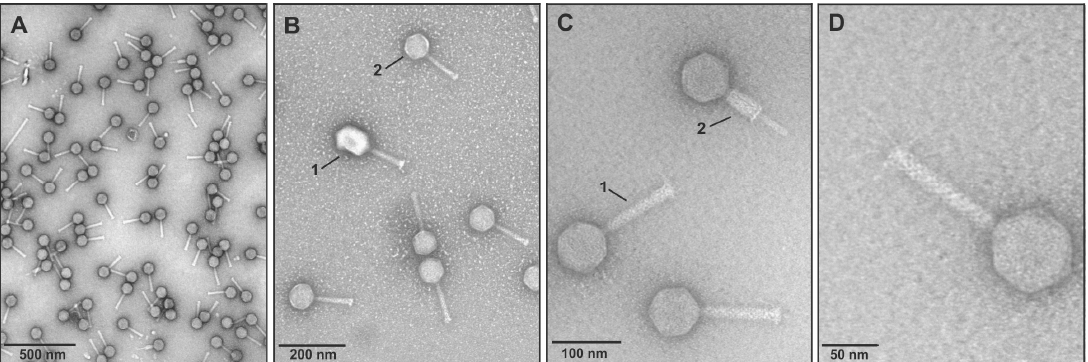
Figure 2. Electron micrographs of bacteriophage VpaE1. ( A and B.2 ) CsCl density gradient-purified VpaE1 and ( B.1 ) T4 particles; ( C ) VpaE1 particles with extended ( C.1 ) and contracted ( C.2 ) tail; and ( D ) close-up view of VpaE1 particle with tail fibers.